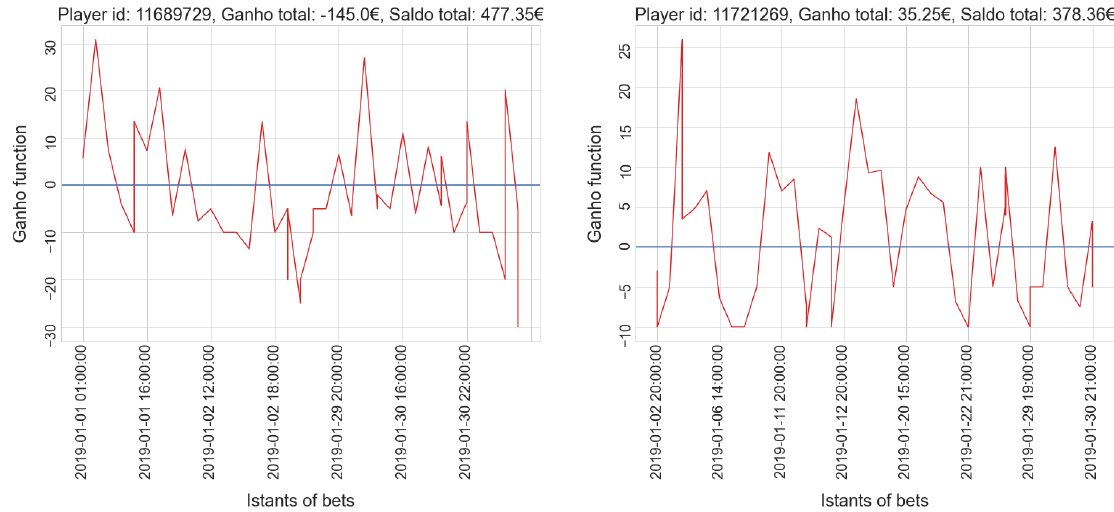
Figure 8. Time series plot of two players in Cluster 1.